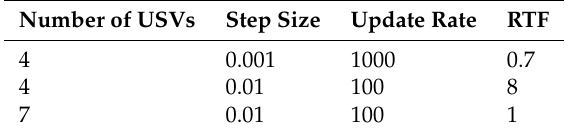
Table 4. Real time factor depending on number of USVs, step size and update